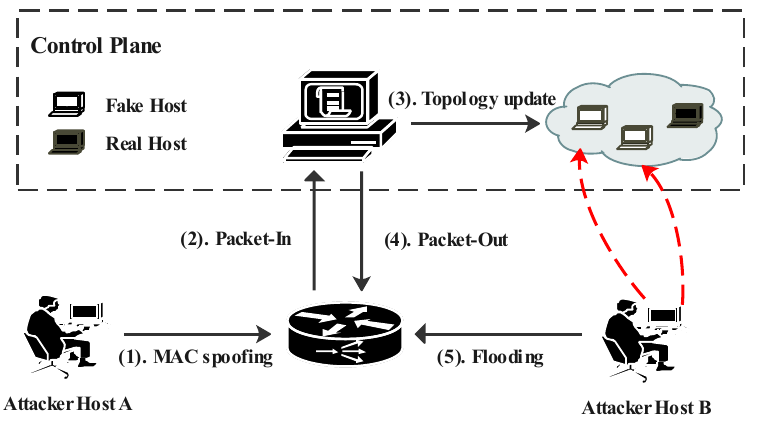
Figure 2. Attack